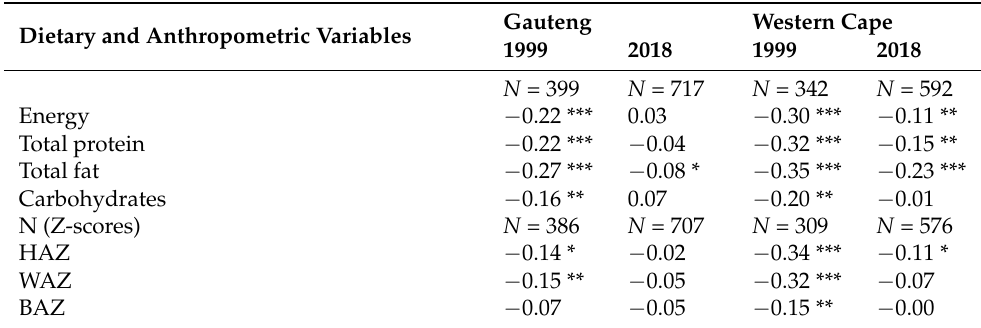
Table 8. Correlation between the hunger score and dietary and anthropometric indicators in 1–<10-year-old children within Gauteng and the Western Cape in 1999 and 2018. Dietary and Anthropometric